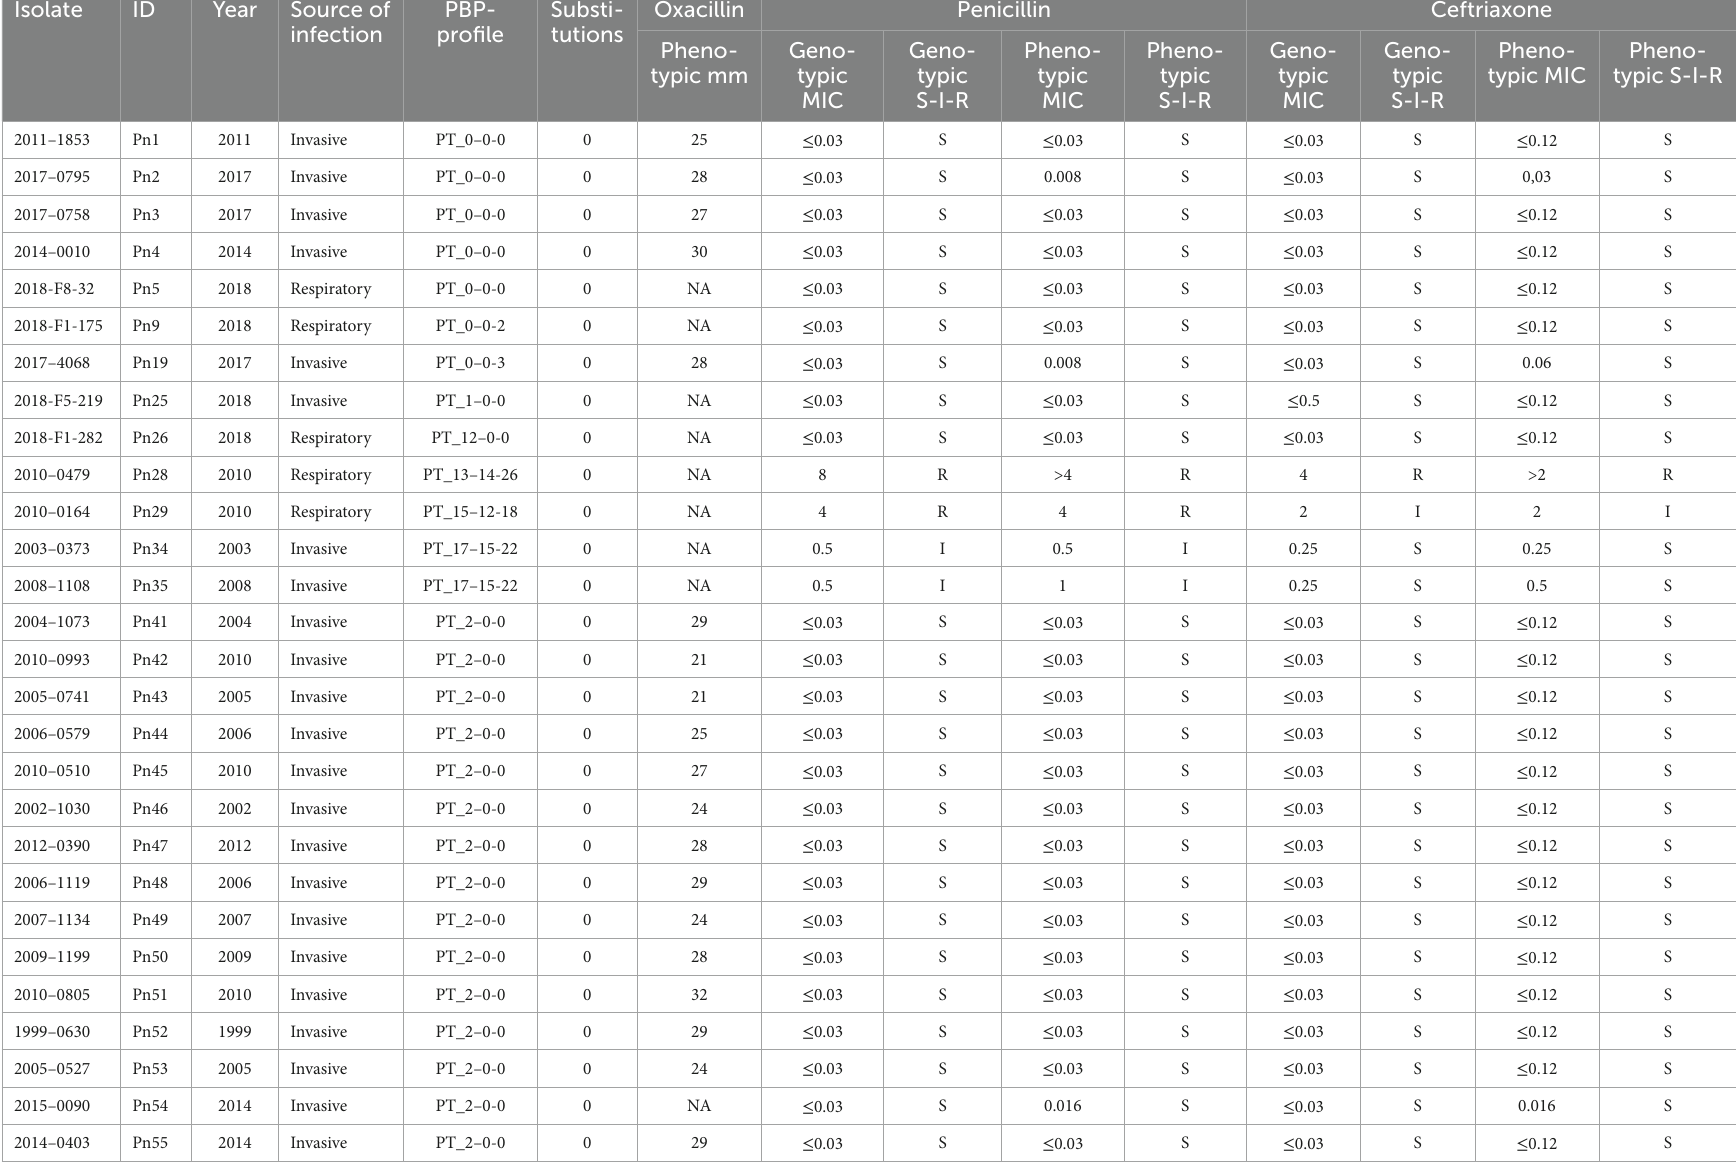
TABLE 3 Genotypic and phenotypic susceptibility in Streptococcus pneumoniae isolates with a recognized PBP-profile.